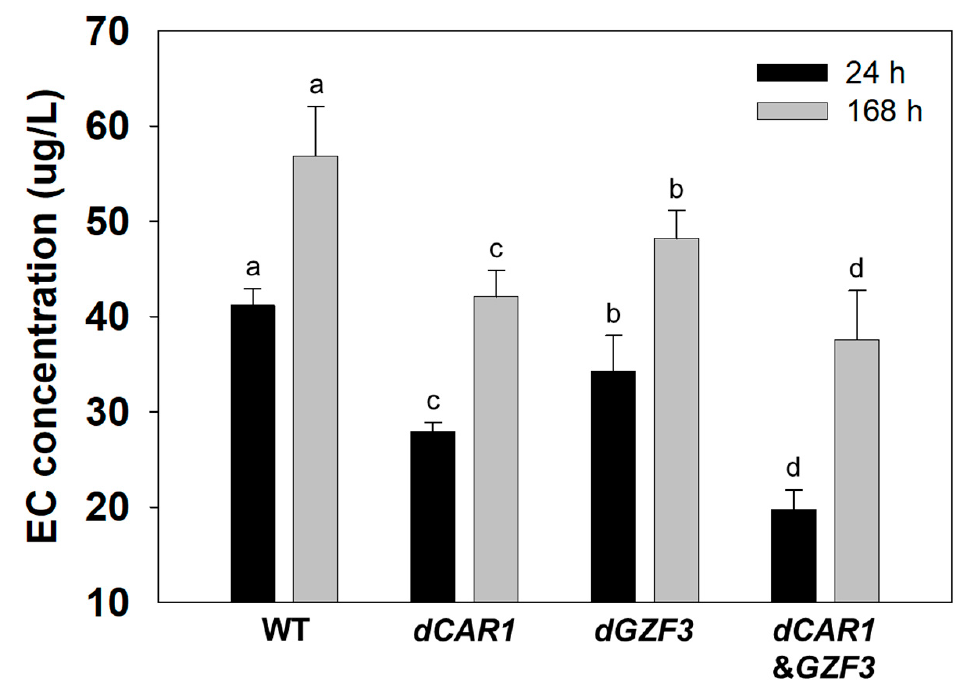
Figure 4. Comparison of EC concentrations in batch fermentations by the wild-type S. cerevisiae GRL6, and the engineered S. cerevisiae dCAR1 , dGZF3 , and dCAR1 & GZF3 strains in the YPD8 medium containing 80 g/L glucose with 50 mg/L urea and 50 mM arginine. Data were analyzed using One-way ANOVA to determine whether the EC concentrations by four strains are any statistically significant differences (a, b, c, and d) between the means of the groups at each time point (24 h or 168 h).